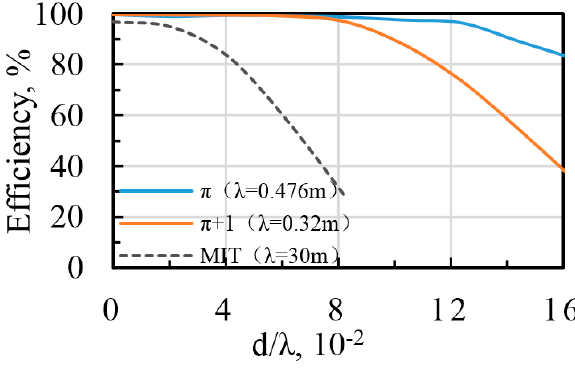
Figure 8. Relationship between radio power transmission efficiency and distance.